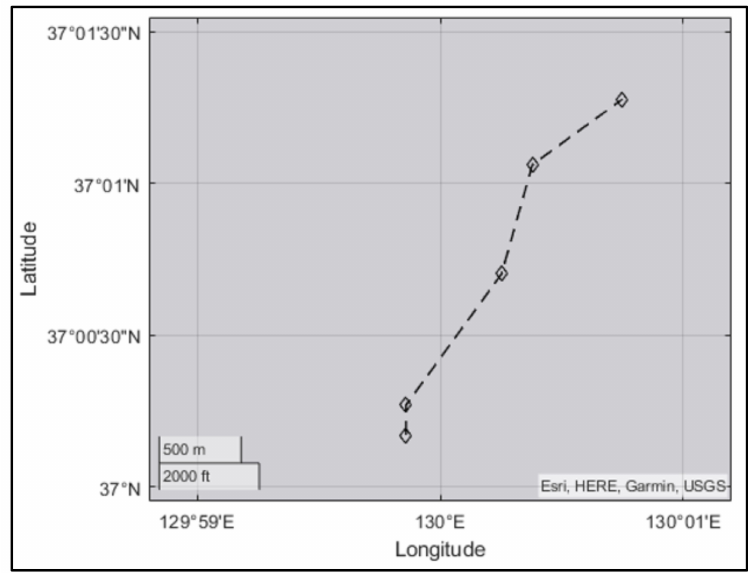
Figure 2. Experiment